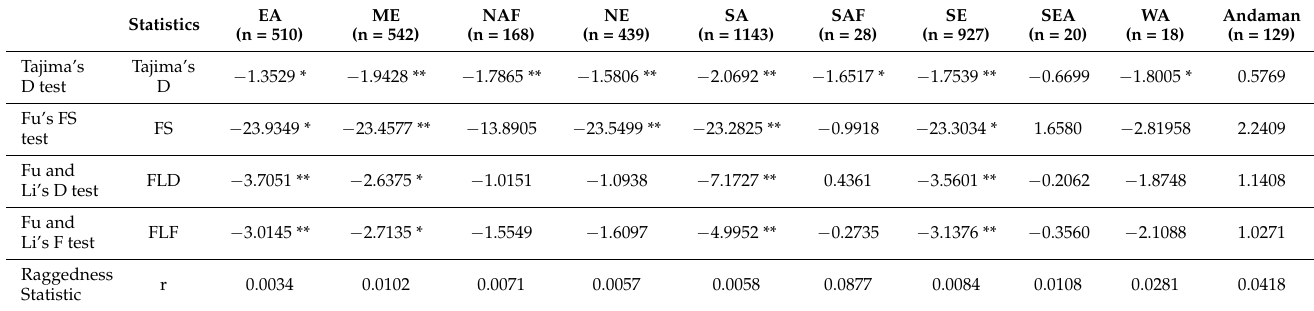
Table 4. Neutrality tests of haplogroup A goats of Andaman and other regions.